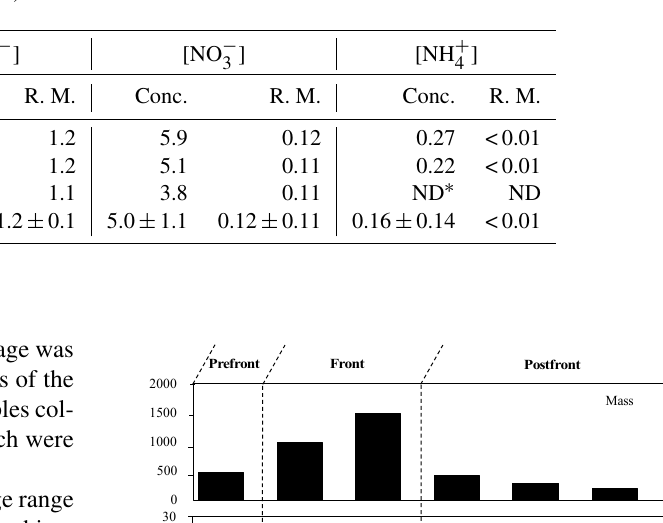
Table 2. Concentration (Conc., in µgm − 3 ) of TSP [M], sulfate [SO 2 − episode. Also included are the relative amounts (R. M., in %) of the three ions in TSP.